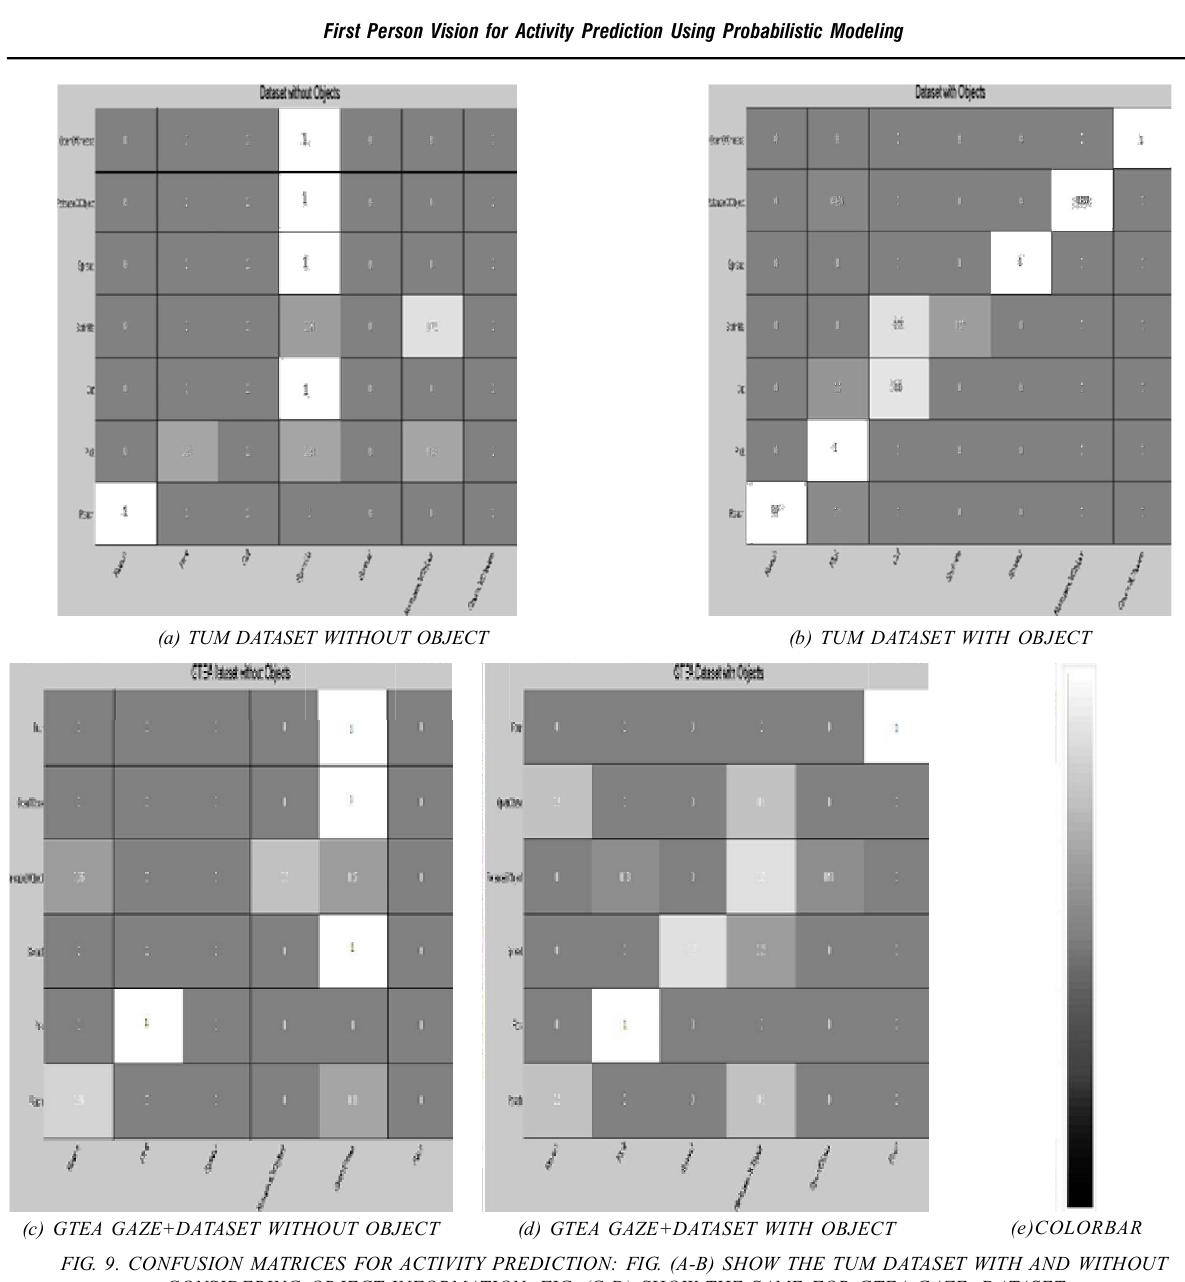
FIG. 9. CONFUSION MATRICES FOR ACTIVITY PREDICTION: FIG. (A-B) SHOW THE TUM DATASET WITH AND WITHOUT CONSIDERING OBJECT INFORMATION. FIG. (C-D) SHOW THE SAME FOR GTEA